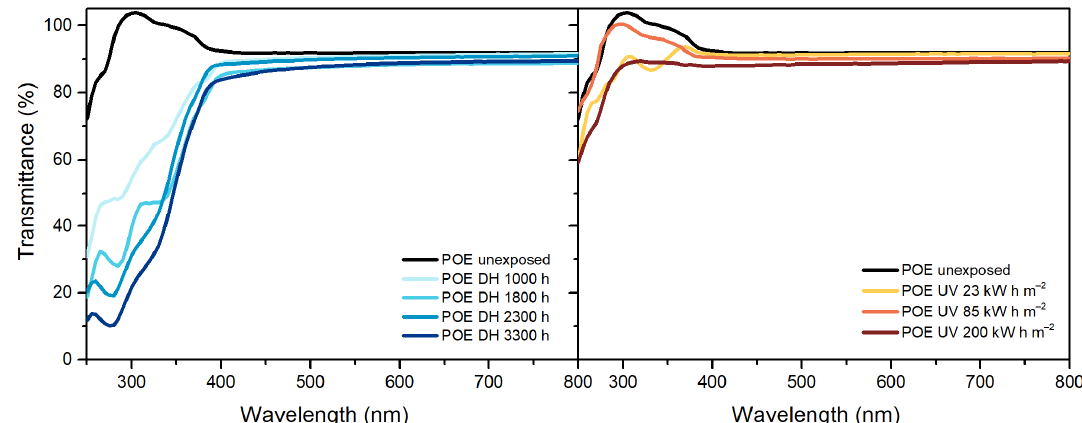
Figure 3. UV-Vis spectra of polyolefin elastomers (POE) unexposed, exposed to DH (left) and UV test (right).